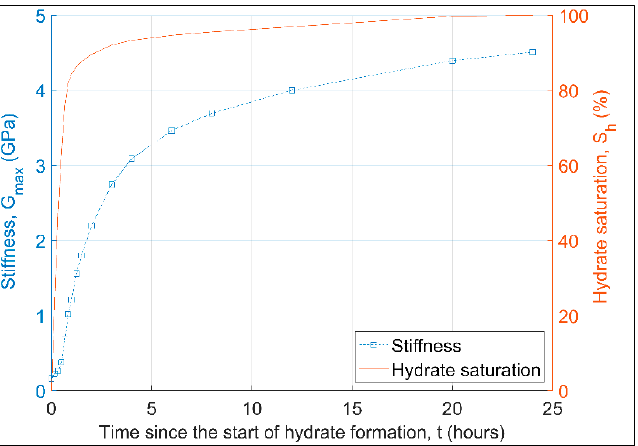
Figure 7. Stiffness evolution with hydrate content during hydrate formation stage for specimen HFT.